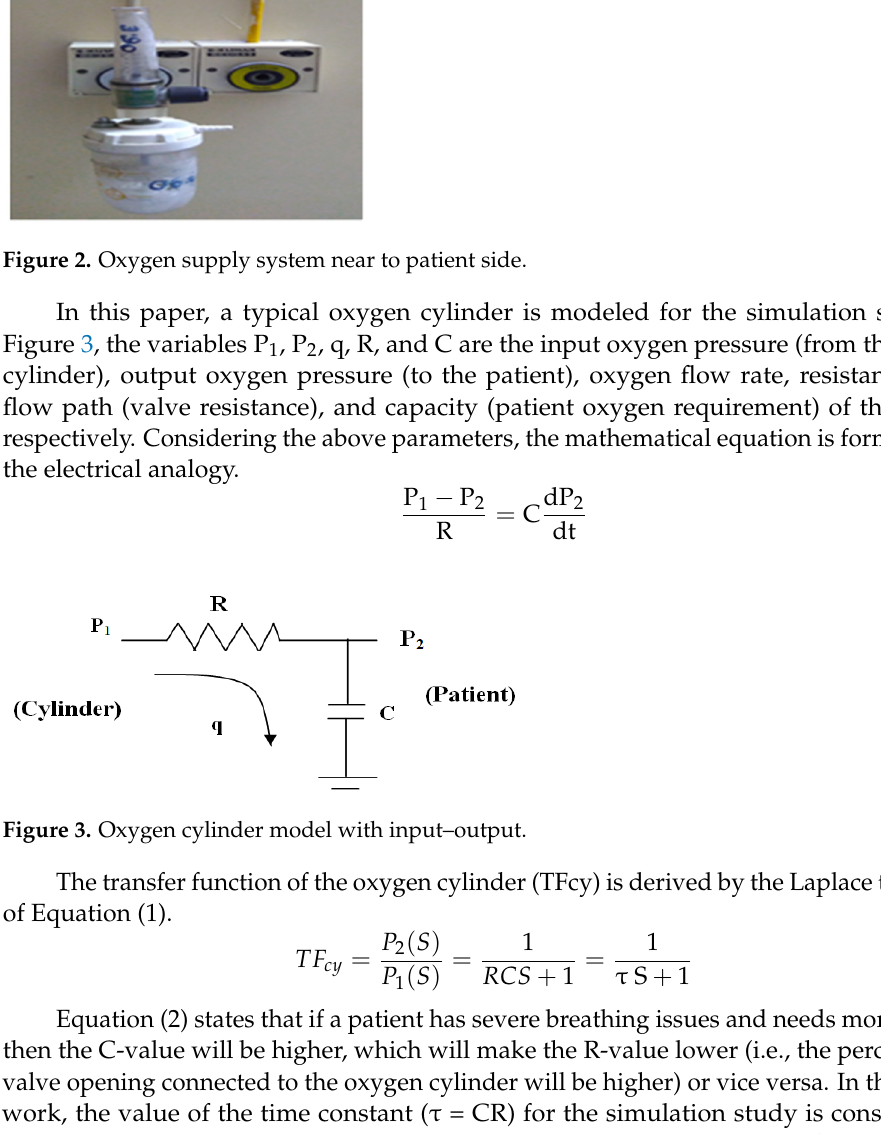
Figure 2. Oxygen supply system near to patient side.